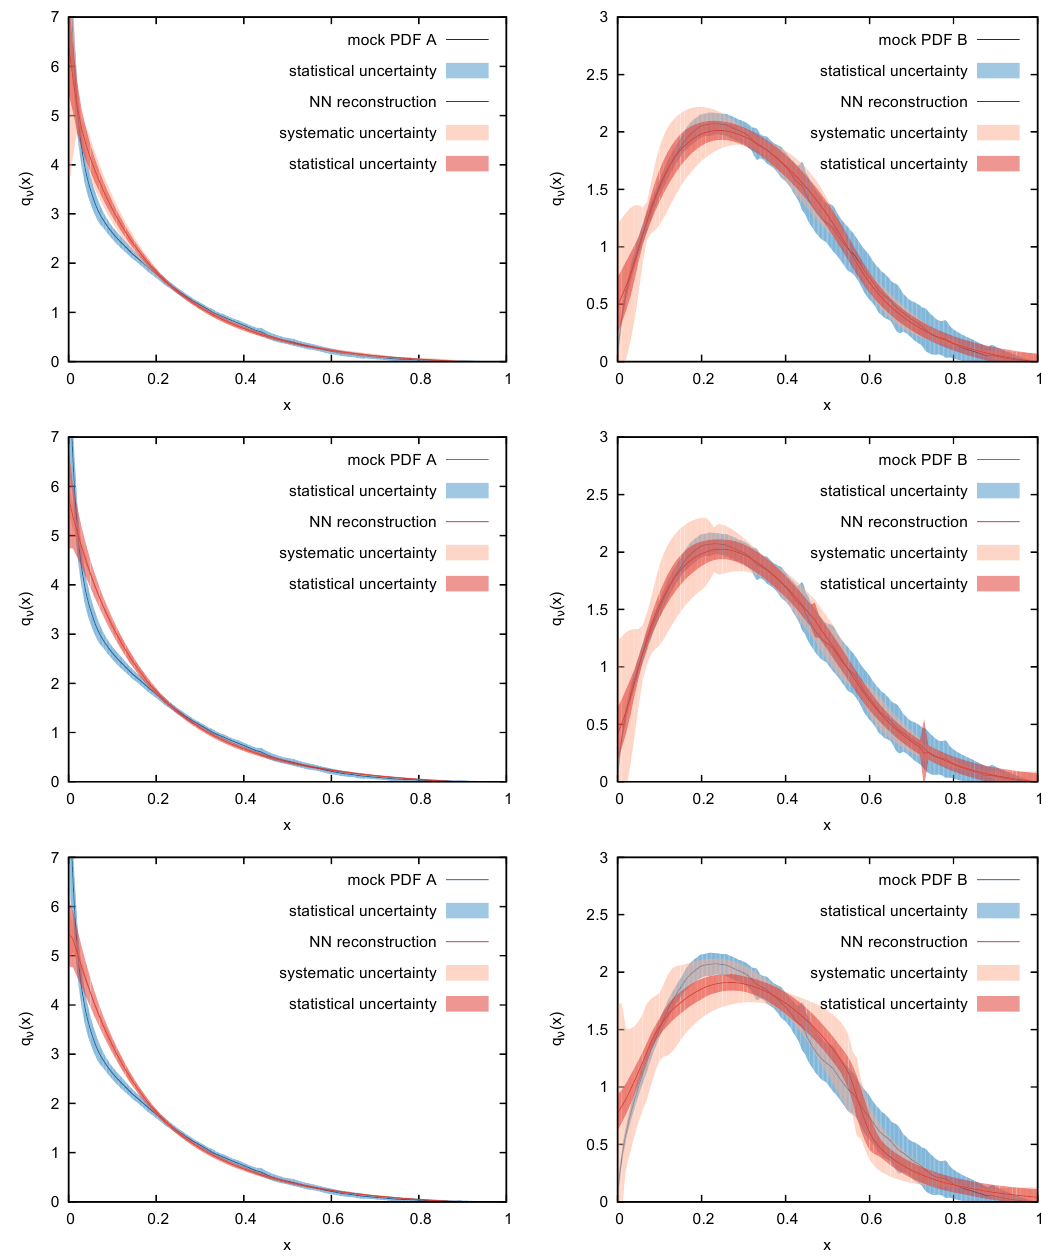
Figure 9 . The genetically trained neural nets. The blue band is the original data. The red band is the reconstructed PDF with statistical and systematic errors. The left column is with NNPDF data. The right column is with modi(cid:12)ed data. The (cid:12)rst row has a network geometry of 1-3-1. The second row has a geometry of 1-4-1. The third row has a geometry of 1-2-2-1.